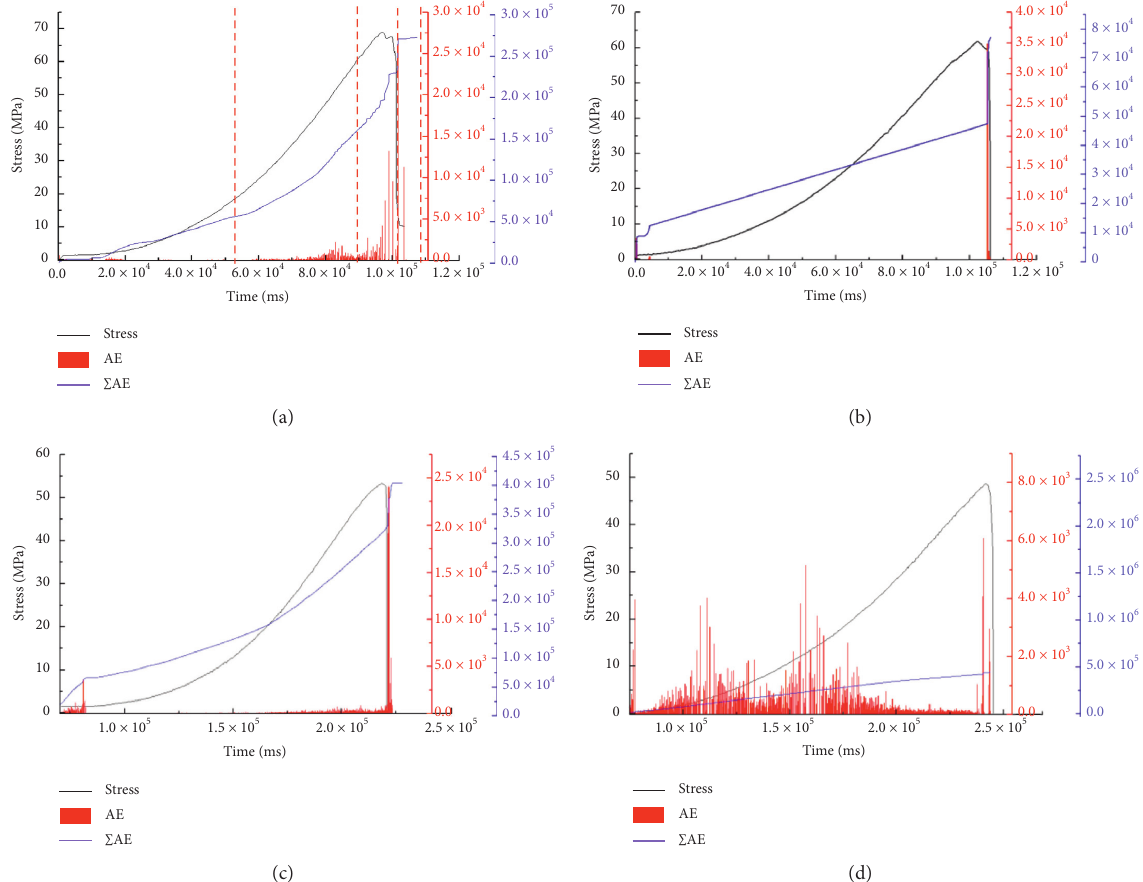
Figure 7: Variation of AE ringing count, the cumulative AE ringing count, and stress with time at different slenderness ratios ( D ). (a)